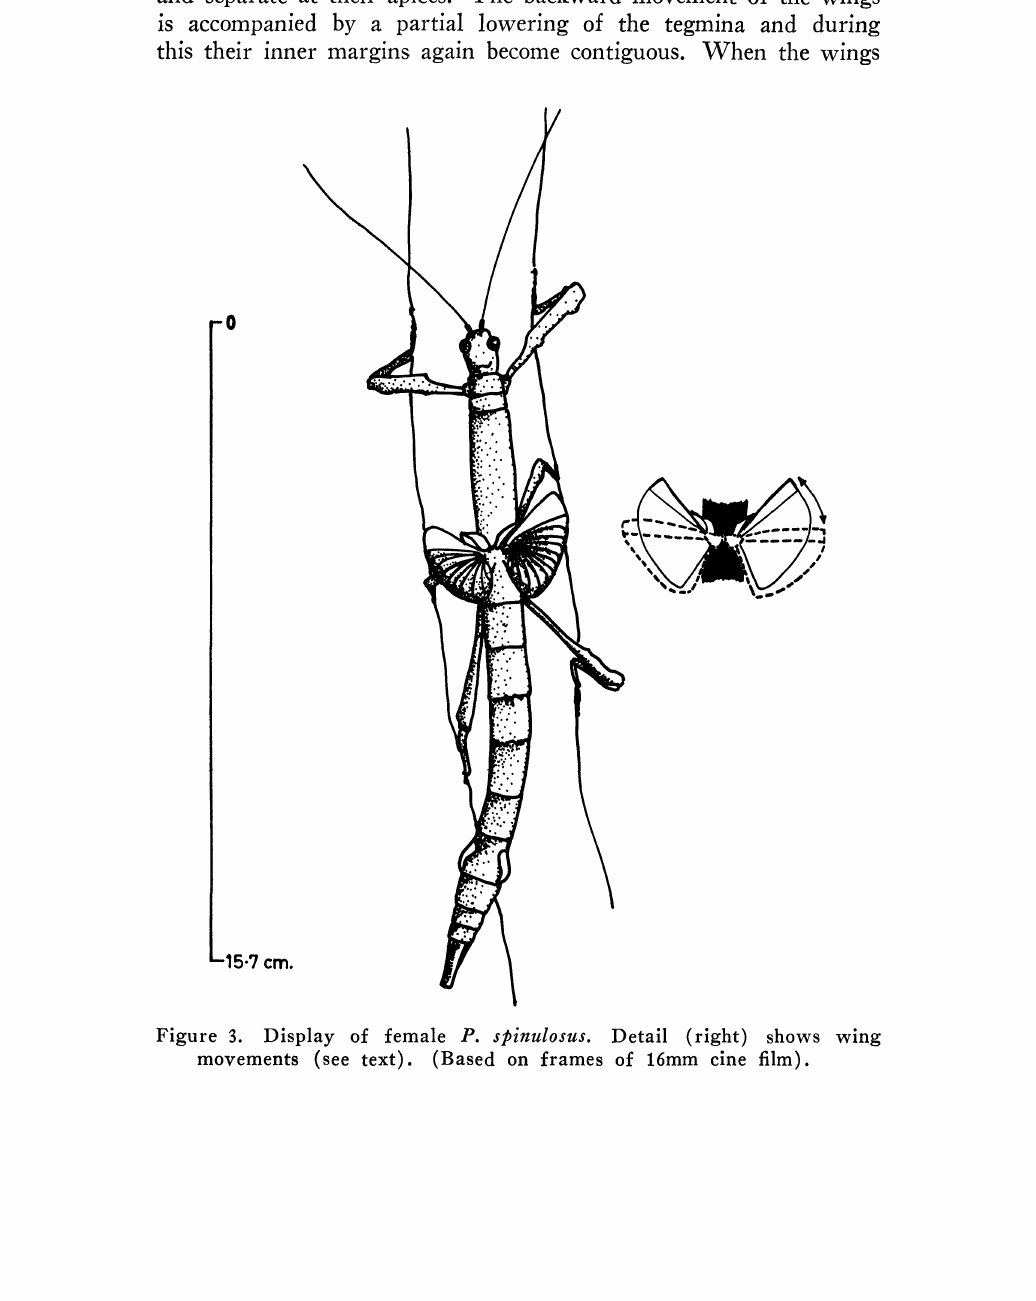
Figure 3. Display of female P..pinulosus. Detail (right) shows wing movements (see text). (Based on frames of 16mm cine